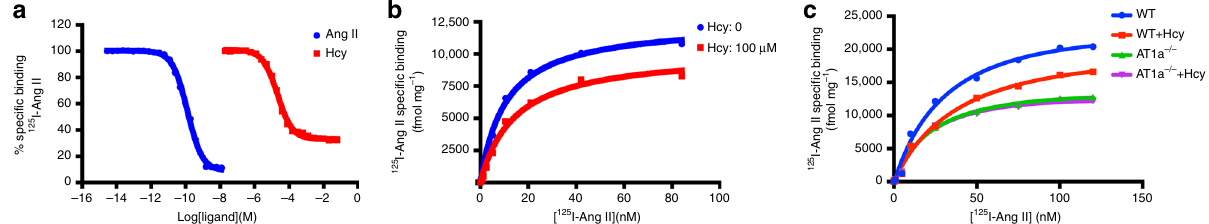
Fig. 3 Hcy directly interacts with the AT1 receptor. a The speci fi c binding of [ 125 I]-Ang II and the AT1 receptor with different competing concentrations of Ang II and Hcy. The data represent as mean ± SEM, N = 6. b The saturation binding curve of [ 125 I]-Ang II and the AT1 receptor in the presence and absence of Hcy (100 μ M). The data represent as mean ± SEM, N = 6. c The saturation binding curve of [ 125 I]-Ang II and the AT1 receptor in membrane proteins extracted from WT and AT1a − / − aortas of mice fed with or without Hcy. The data represent as mean ± SEM, N